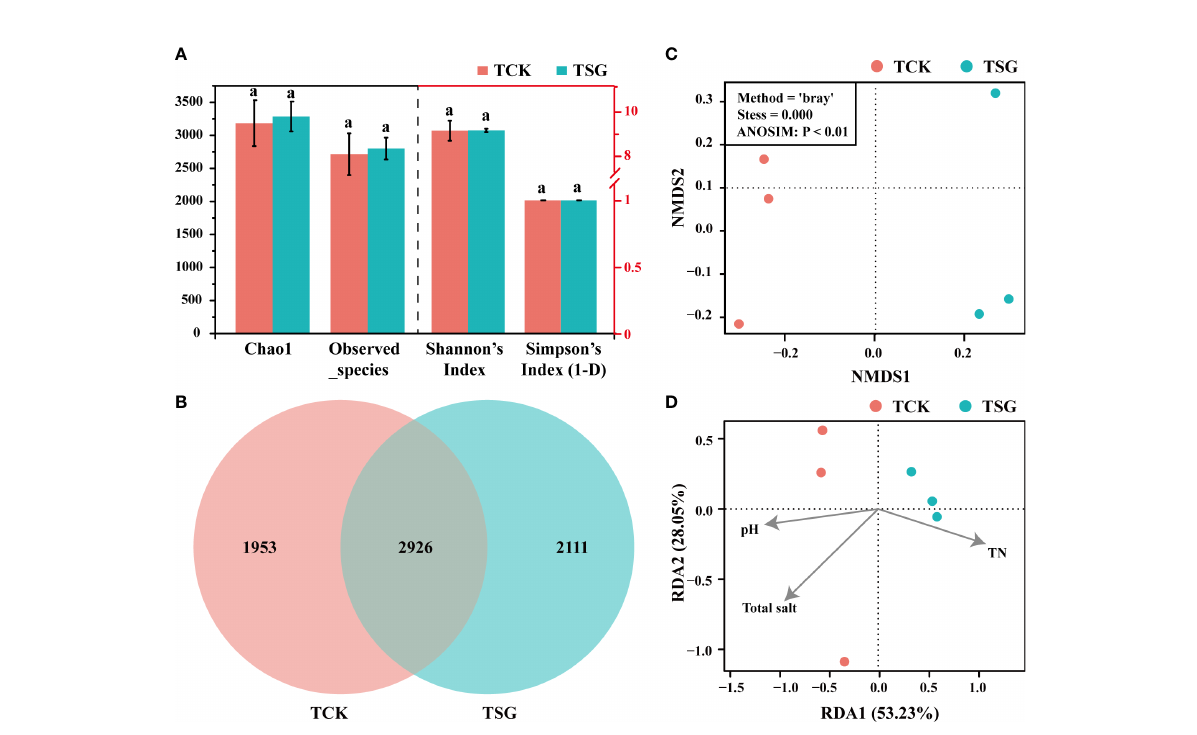
FIGURE 2 (A) Analysis of alpha diversity (The different lowercase letters of the same index in different sample groups indicate that there is a signi fi cant difference between the groups in this index [according to Duncan ’ s signi fi cance test, P < 0.05)]; (B) Venn diagram showing the number of shared/unique OTUs between two groups of samples; (C) NMDS diagram showing bacterial community differences between two sample groups; (D) RDA diagram showing the correlation between bacterial community composition and environmental factors in the two groups of